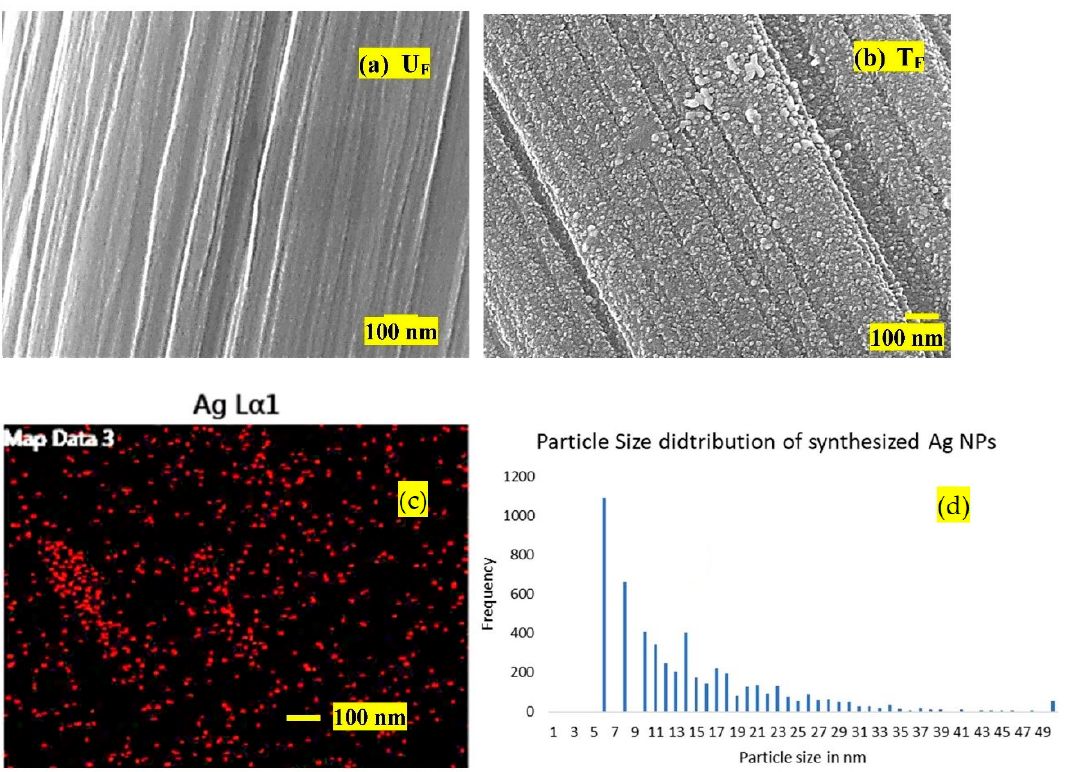
Figure 4. FE-SEM micrographs of ( a ) U F and ( b ) (T F ): ( c ) EDS data (Ag dot map) for T F and ( d ) particle size distribution for Ag NPs.